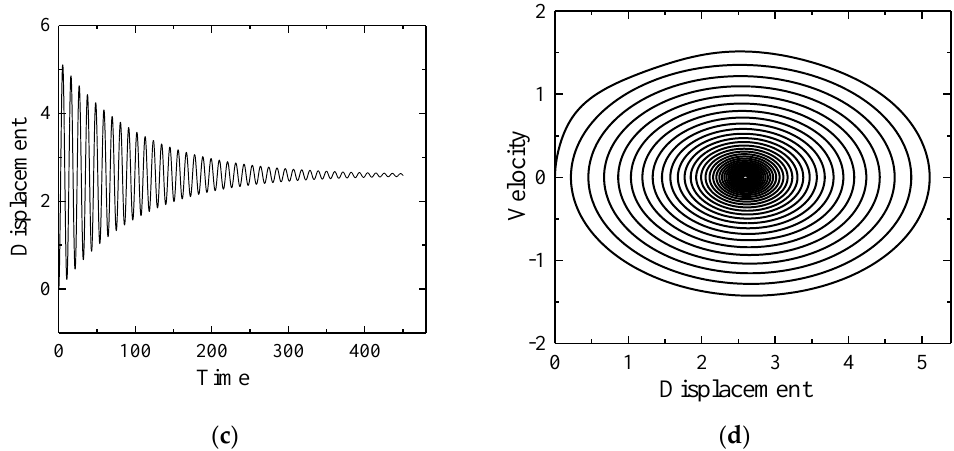
Figure 21. Evolutions of the displacement and speed-displacement diagram of brake disc and brake shoe at the stiffness of k 1 = 0.5 N/m and k 2 = 1 N/m. ( a ) Evolution of the displacement of the brake shoe. ( b ) Evolution of the speed-displacement diagram of the brake shoe. ( c ) Evolution of the displacement of the brake disc. ( d ) Evolution of the speed-displacement diagram of the brake disc.